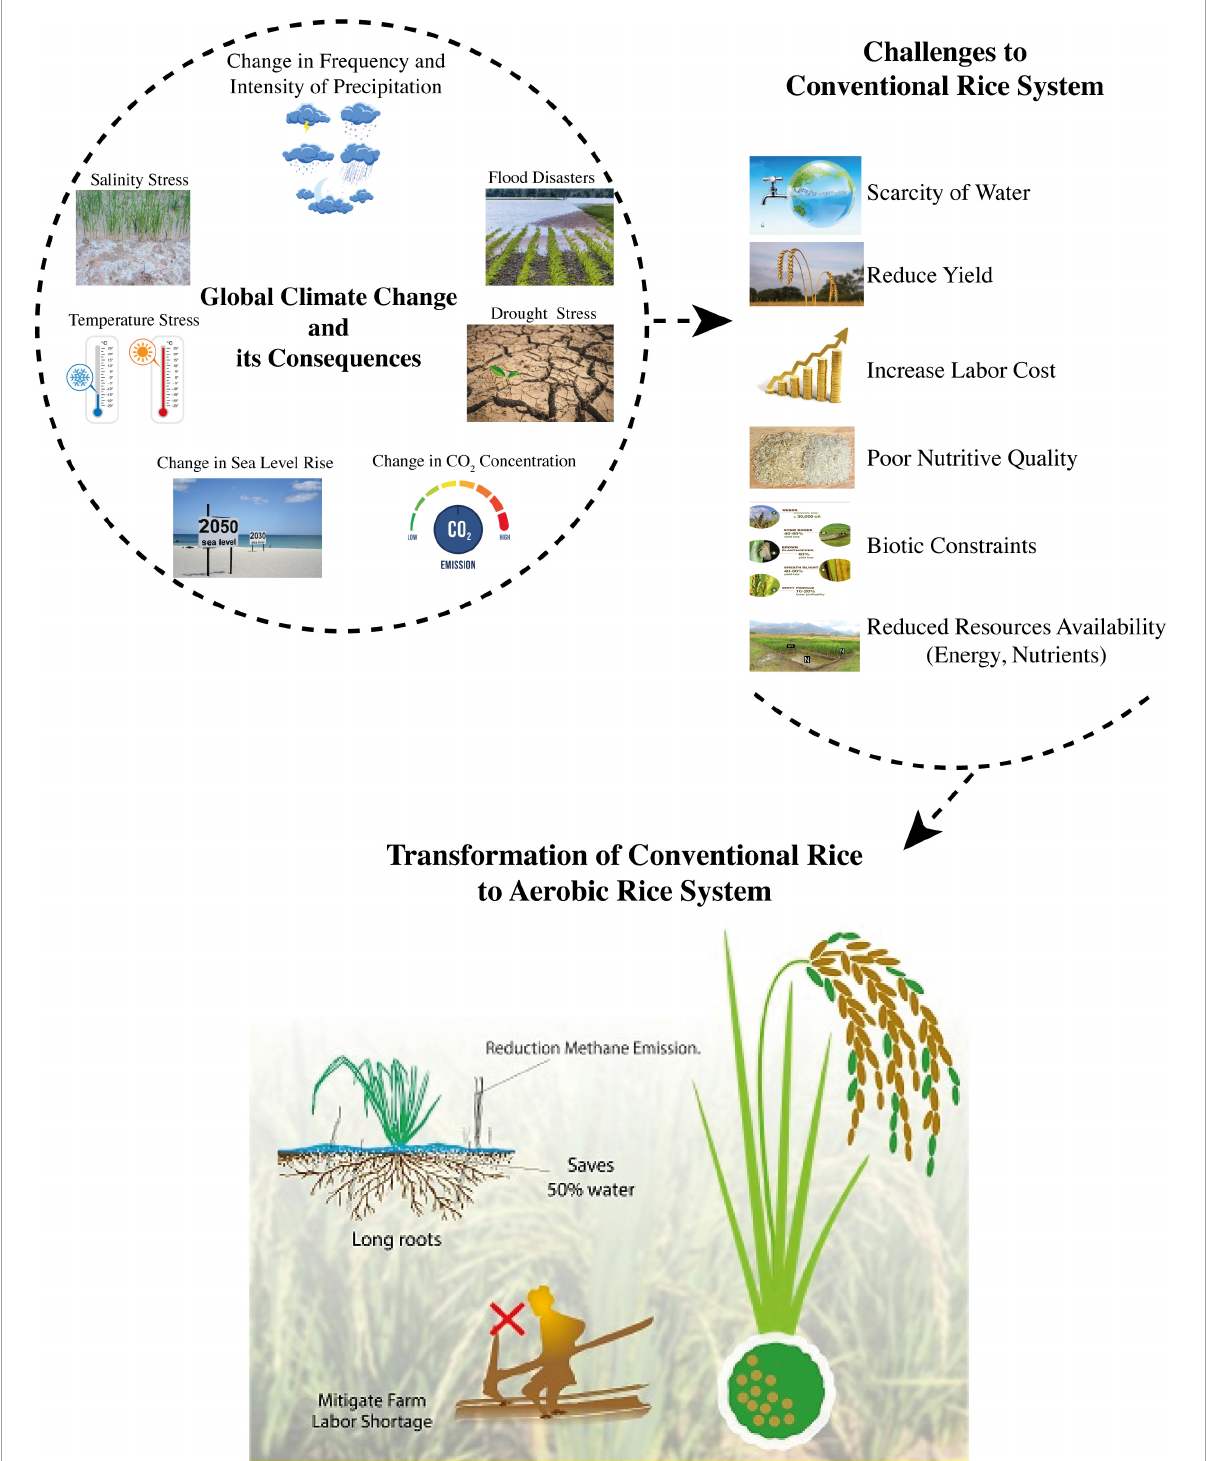
FIGURE1 Global climate change and challenges to rice production (Sources: Horie, 2019; Hu et al., 2019; Elbasiouny and Elbehiry, 2020; Song et al., 2022).